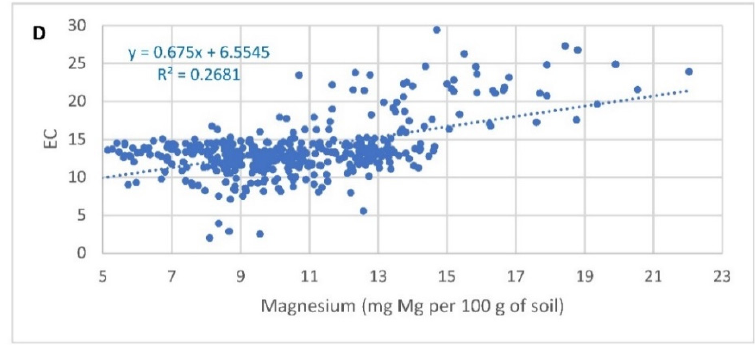
Figure 3. Relationships between EC versus pH and content of macronutrients.